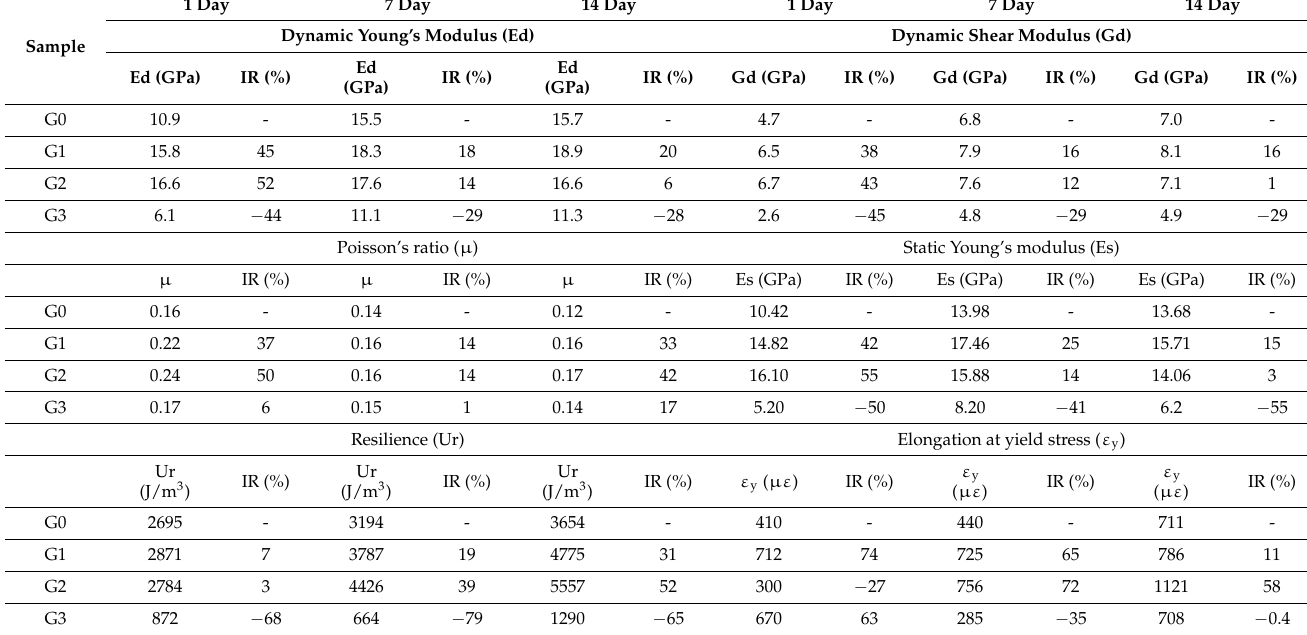
Table 3. Elastic properties at 1, 7 and 14 days.